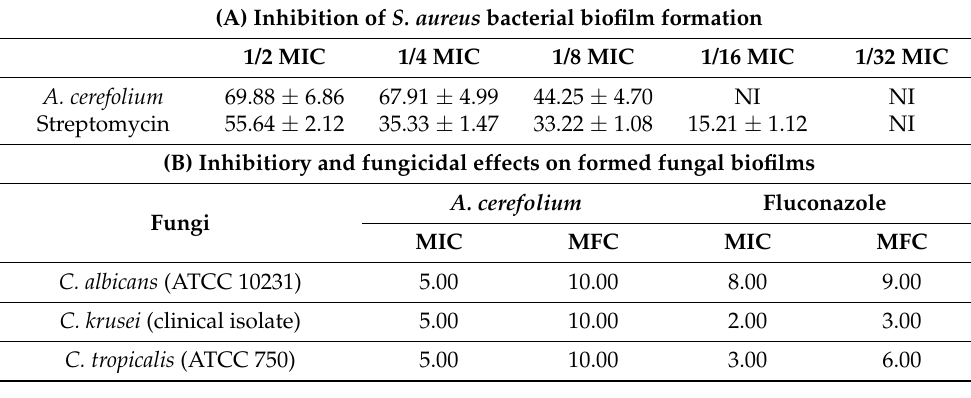
Table 4. The effects of A. cerefolium methanolic extract on: ( A ) bacterial biofilm formation by S. aureus at sub-MICs (%) and ( B ) on MIC and MFC (mg/mL) in formed fungal